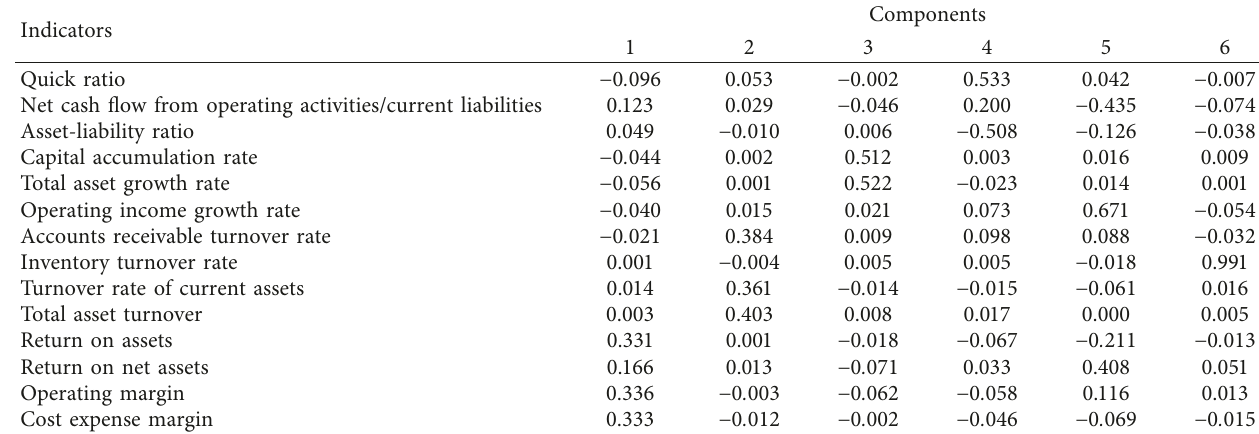
Table 5: Principal component extraction.